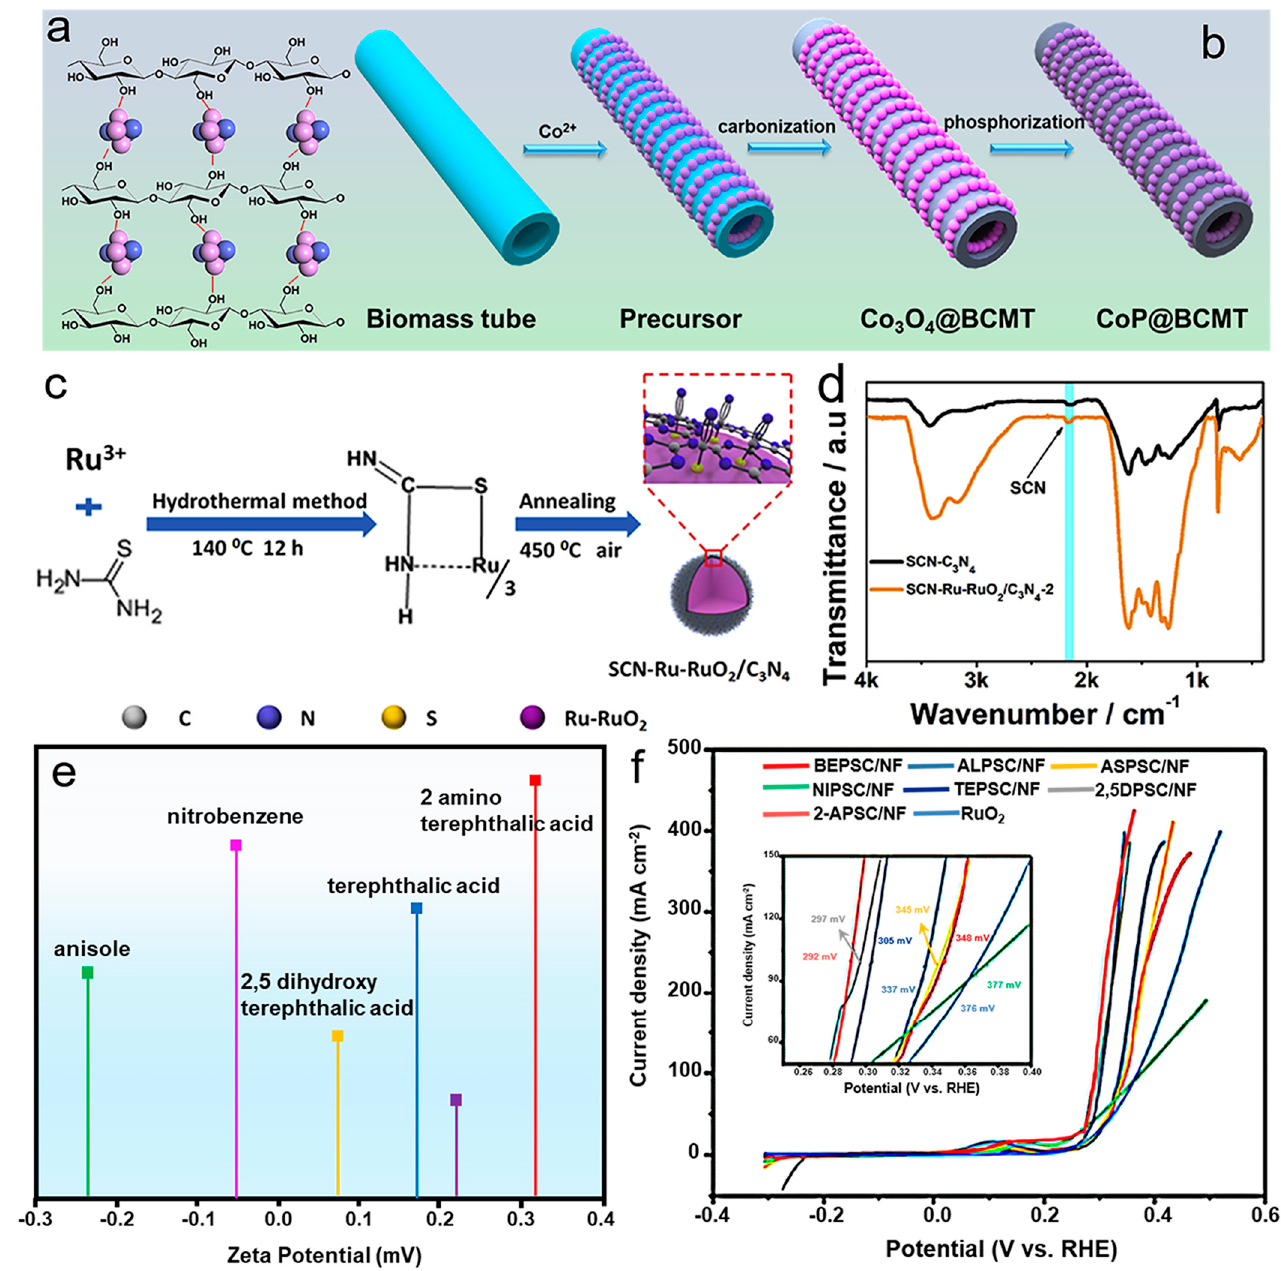
Figure 5. ( a ) Schematic diagram of hydroxyl groups (C − OH) on the surface of biomass. ( b ) The syn- thesis process of CoP@BCMT. Reproduced with permission of [12], copyright 2022 Elsevier. ( c ) Prep- aration process of SCN − Ru − RuO 2 /C 3 N 4 . ( d ) The FTIR of SCN − C 3 N 4 and SCN − Ru − RuO 2 /C 3 N 4 . Re- produced with permission of [44], copyright 2020 Elsevier. ( e ) The zeta potential of ligands (anisole, benzene, nitrobenzene, 2,5 dihydroterephthalic acid, terephthalic acid, aniline, and 2-aminotereph- thalic acid) in DMF. ( f ) LSV curves of PSC/NF modulated with various ligands for OER. Reproduced with permission of [45], copyright 2021 Elsevier.